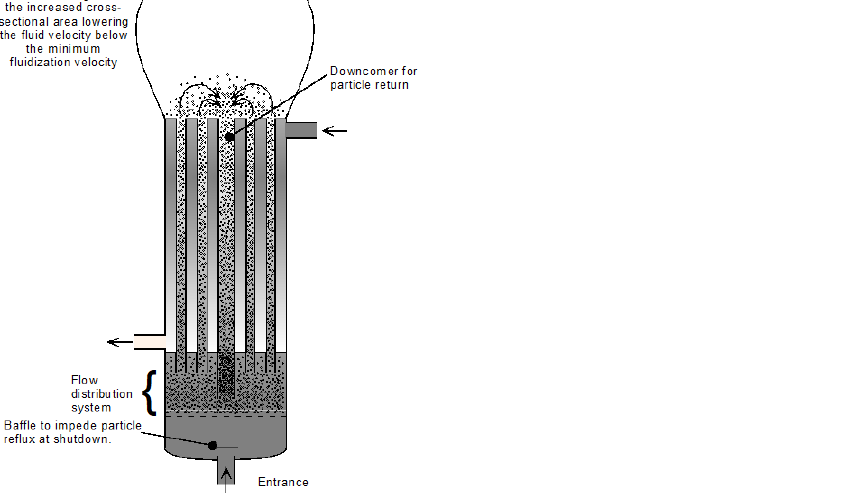
Figure 1. Liquid/solid fluidized bed heat exchanger with internal particle re-circulation . Fluidized bed continuous phase superficial velocities can be increased by several transport regime. Beds can also have their apparent gravitational force increased by using